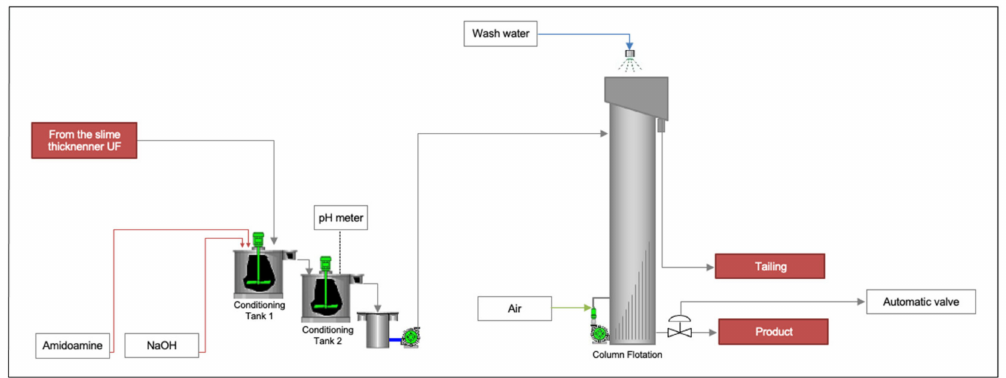
Figure 2. Pilot plant flowsheet.